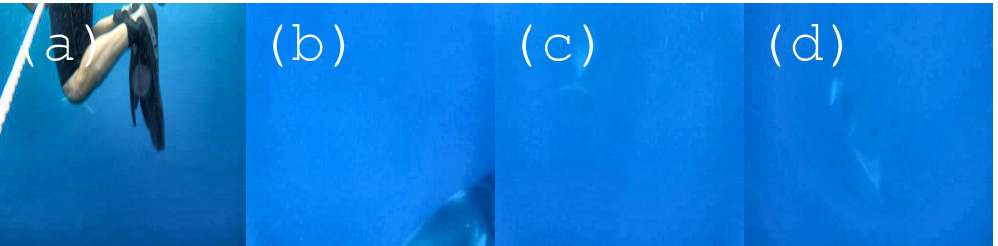
Figure 5. Sub-figures: ( a – d ) are examples of false-positive classification errors by MWD-v2 after the second train-predict project cycle. Note, ( d ) is possibly a labelling error.